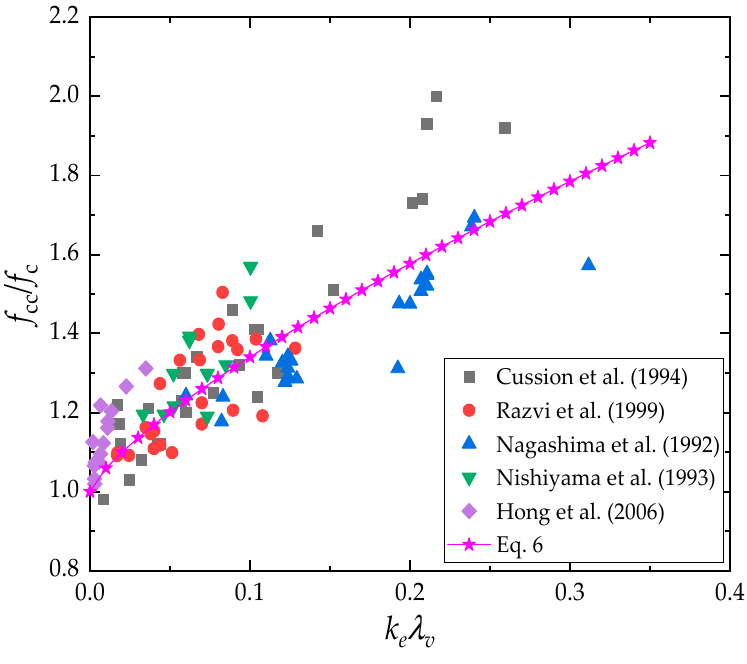
Figure 8. Relationship between cc c f /f and e v k λ [8,9,20,37,38].